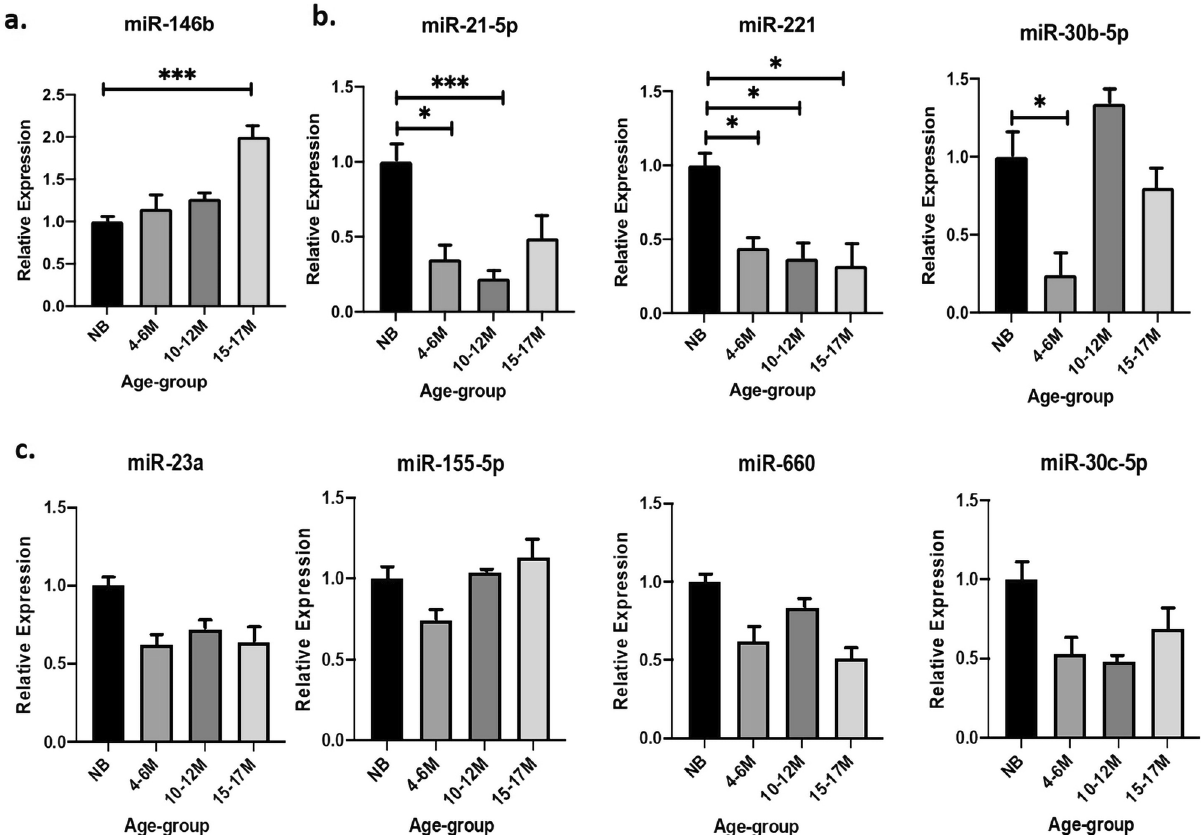
Figure 4. qRT-PCR expression profiles of arbitrarily selected skeletal muscle related miRNAs. Plasma miRNAs have been shown as DE in ( a ) upward direction, ( b ) downward direction and ( c ) not DE. Relative expression is expressed as fold change (mean ± SEM) and statistical significance as *p < 0.05, **p < 0.005, ***p <